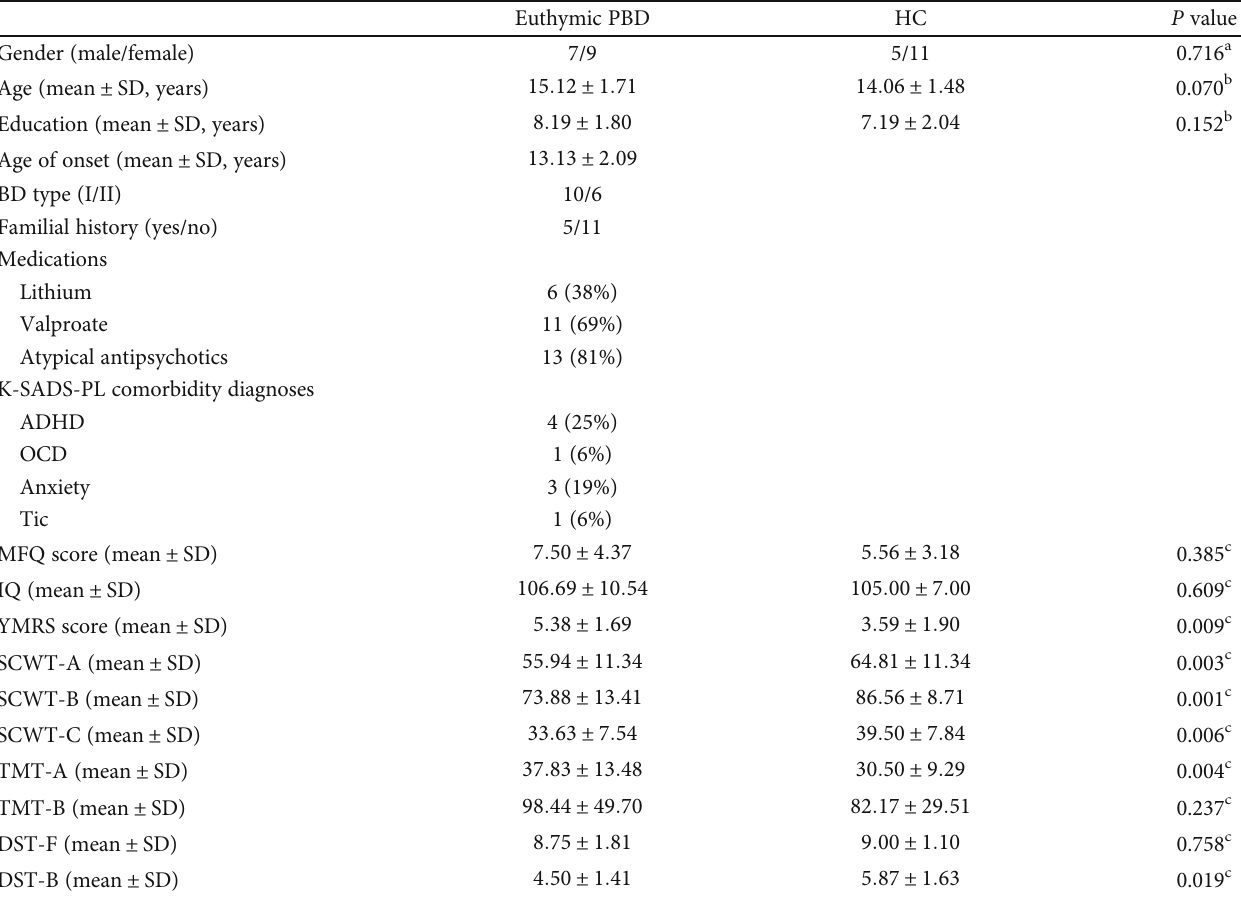
Table 1: Comparison of clinical and neuropsychological measurement between the euthymic PBD patients and healthy